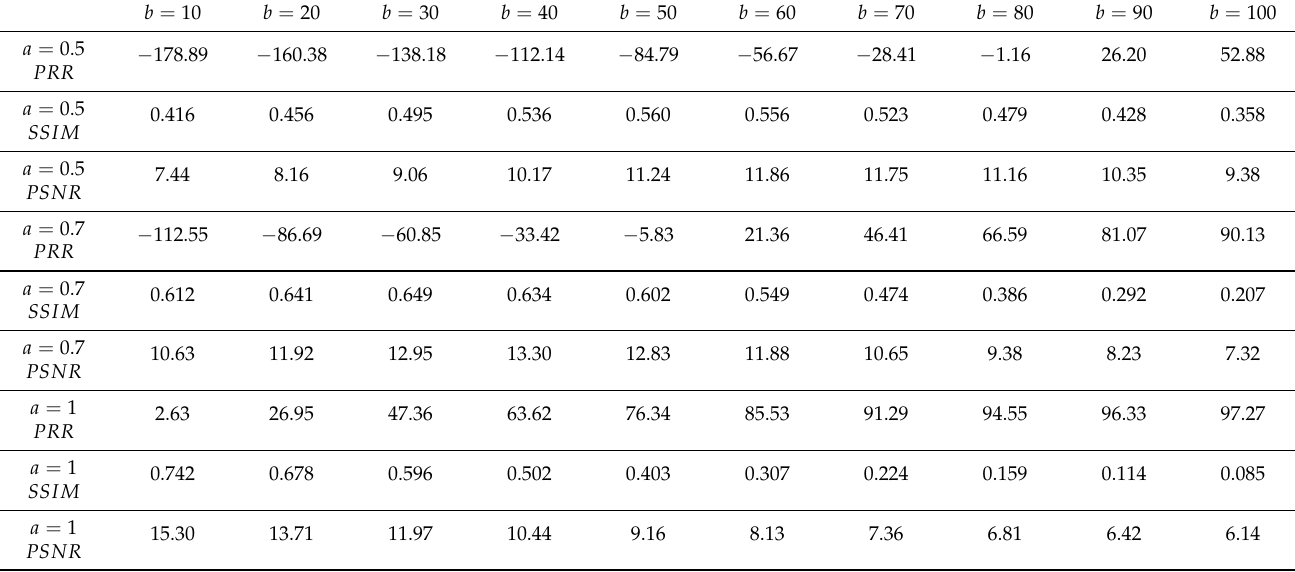
Table 9. Baboon image performance metrics with HE for a = { 0.5,0.7,1 } and b = [10:10:100].